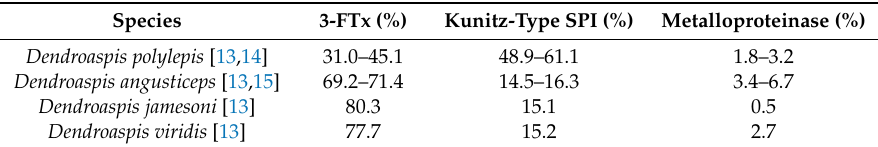
Table 1. Species and venom proteomes of snake venoms